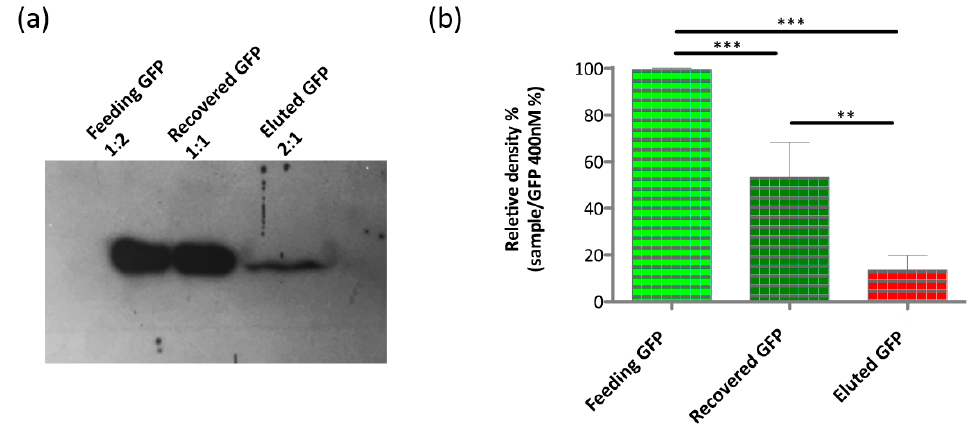
Figure 6. Western blot analysis ( a ) and relative density percentage ( b ) performed on the feeding solution of GFP (light green bar), GFP recovered after incubation (dark green bar), and GFP eluted from the solid support (red bar). The reported values have been averaged over 3 measurements. Error bars represent standard deviation (SD) (*** p < 0.001, ** p < 0.01).